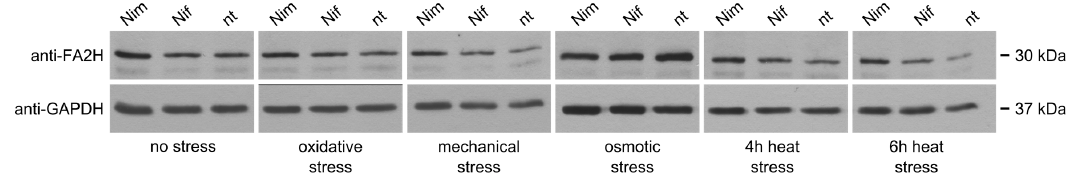
Figure 5. FA2H protein levels in undifferentiated Neuro2a cells. 20 μ g total protein was loaded per